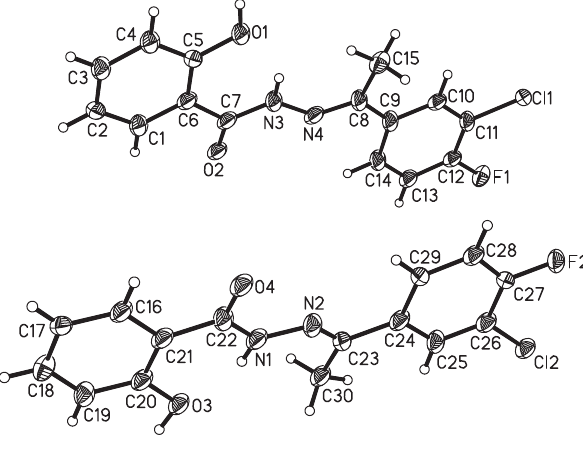
Table 1: Data collection and handling.